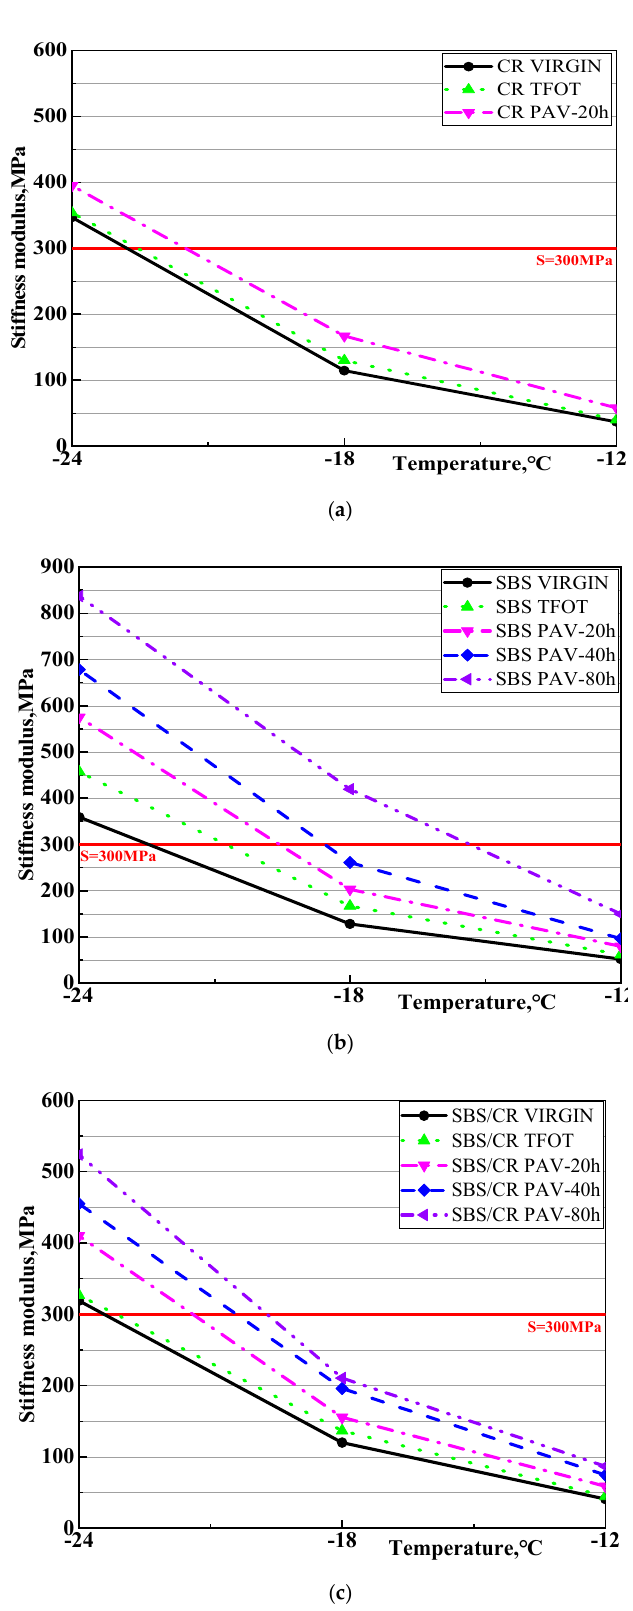
Figure 7. The evolution of stiffness modulus under different aging conditions of all selected asphalt binders, ( a ) Crumb Rubber modified binders; ( b ) Styrene-butadiene-styrene Modified binders; ( c ) Styrene-butadiene-styrene /Crumb Rubber Modified binders